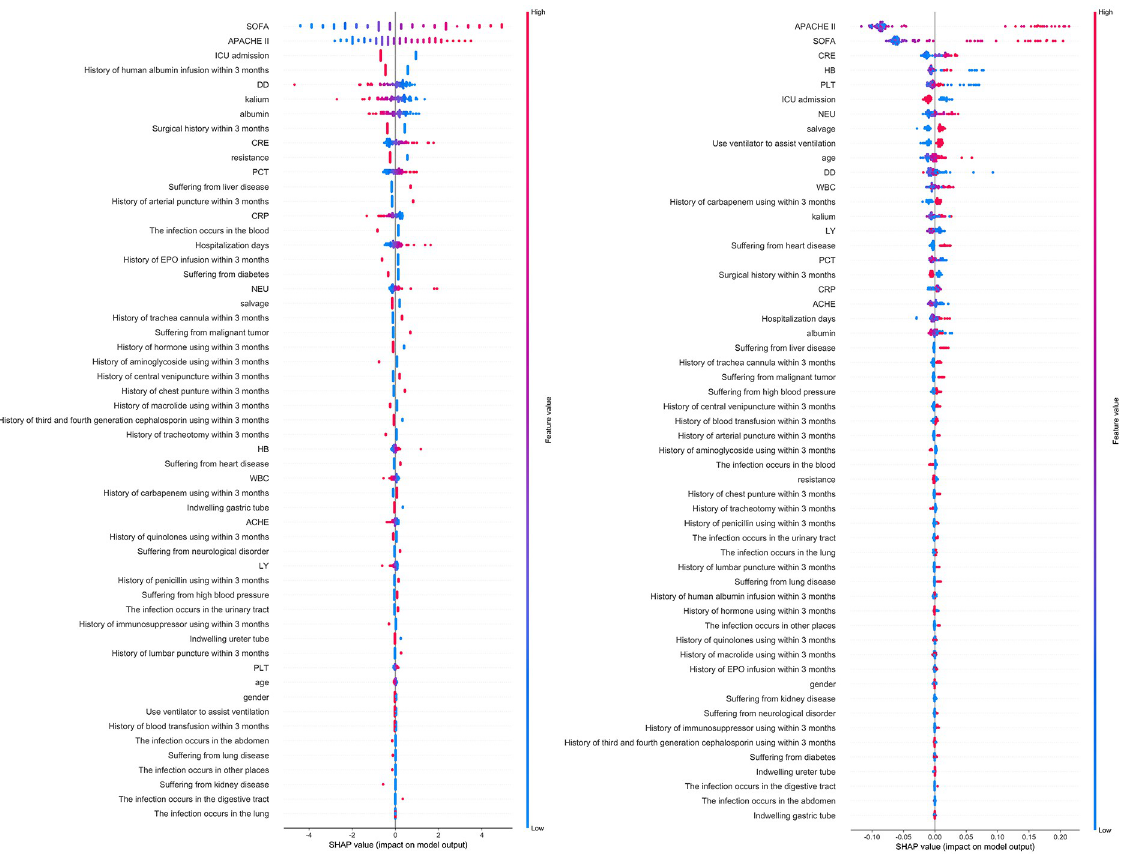
Fig 3. SHAP values of the LR model (left) and RF model